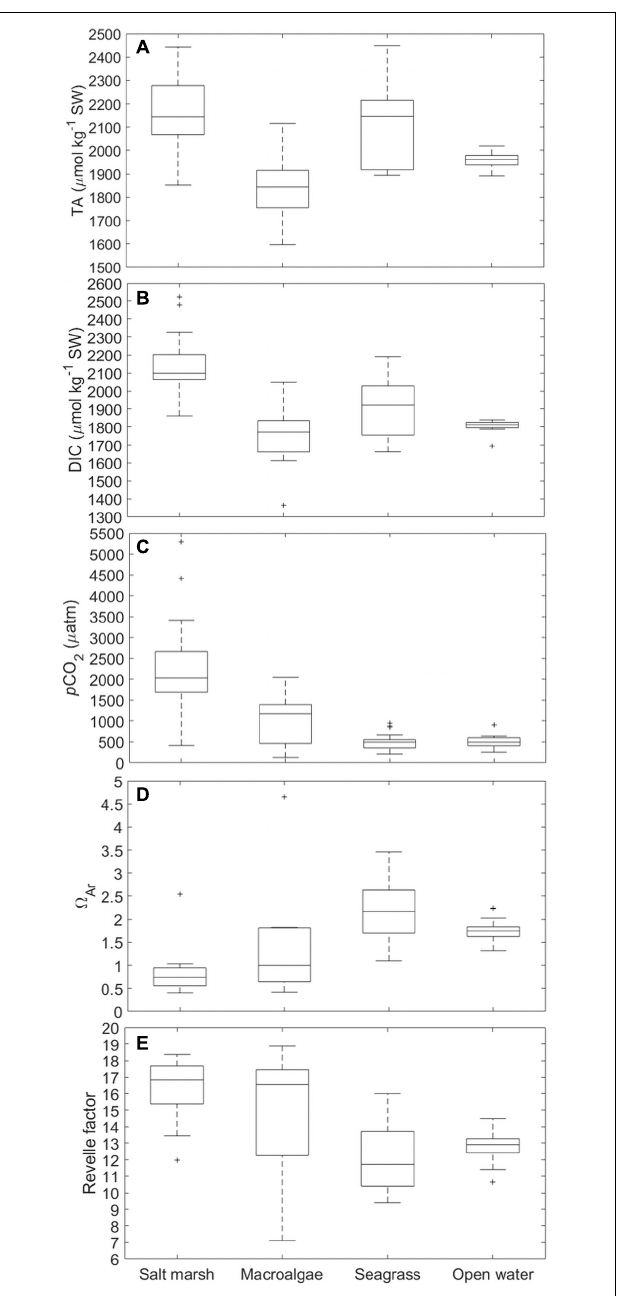
FIGURE 7 | Box and whisker plots of (A) TA ( µ mol kg − 1 SW), (B) DIC ( µ mol kg − 1 SW), (C) p CO 2 ( µ atm), (D) (cid:127) Ar , and (E) Revelle factor for four habitat types (SM-3, MA-1, SG-1, OW-1). On each box, the central mark indicates the median, and the bottom and top edges of the box indicate the 25th and 75th percentiles, respectively. The whiskers extend to the most extreme data points not considered outliers, and the outliers are plotted individually using the “+” symbol.